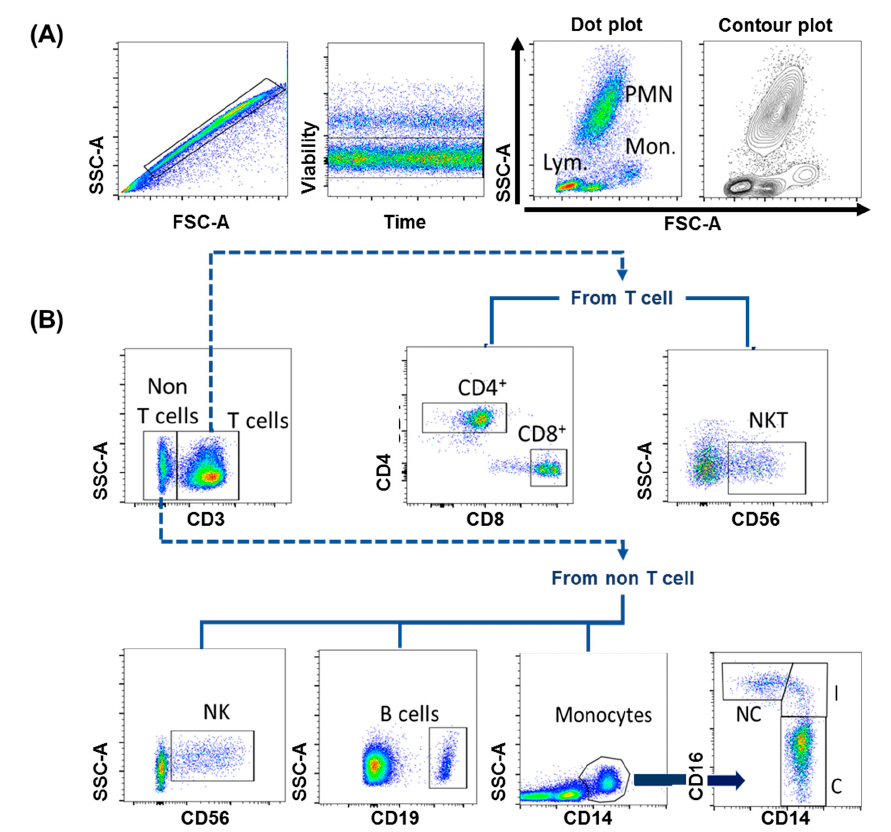
Figure 3. Mononuclear cells of blood circulation, evaluated by FCM. Peripheral blood mononuclear cells (PBMC) were labelled with mAb-F, targeting the CD56, CD3, CD4, CD8, CD19, CD14,